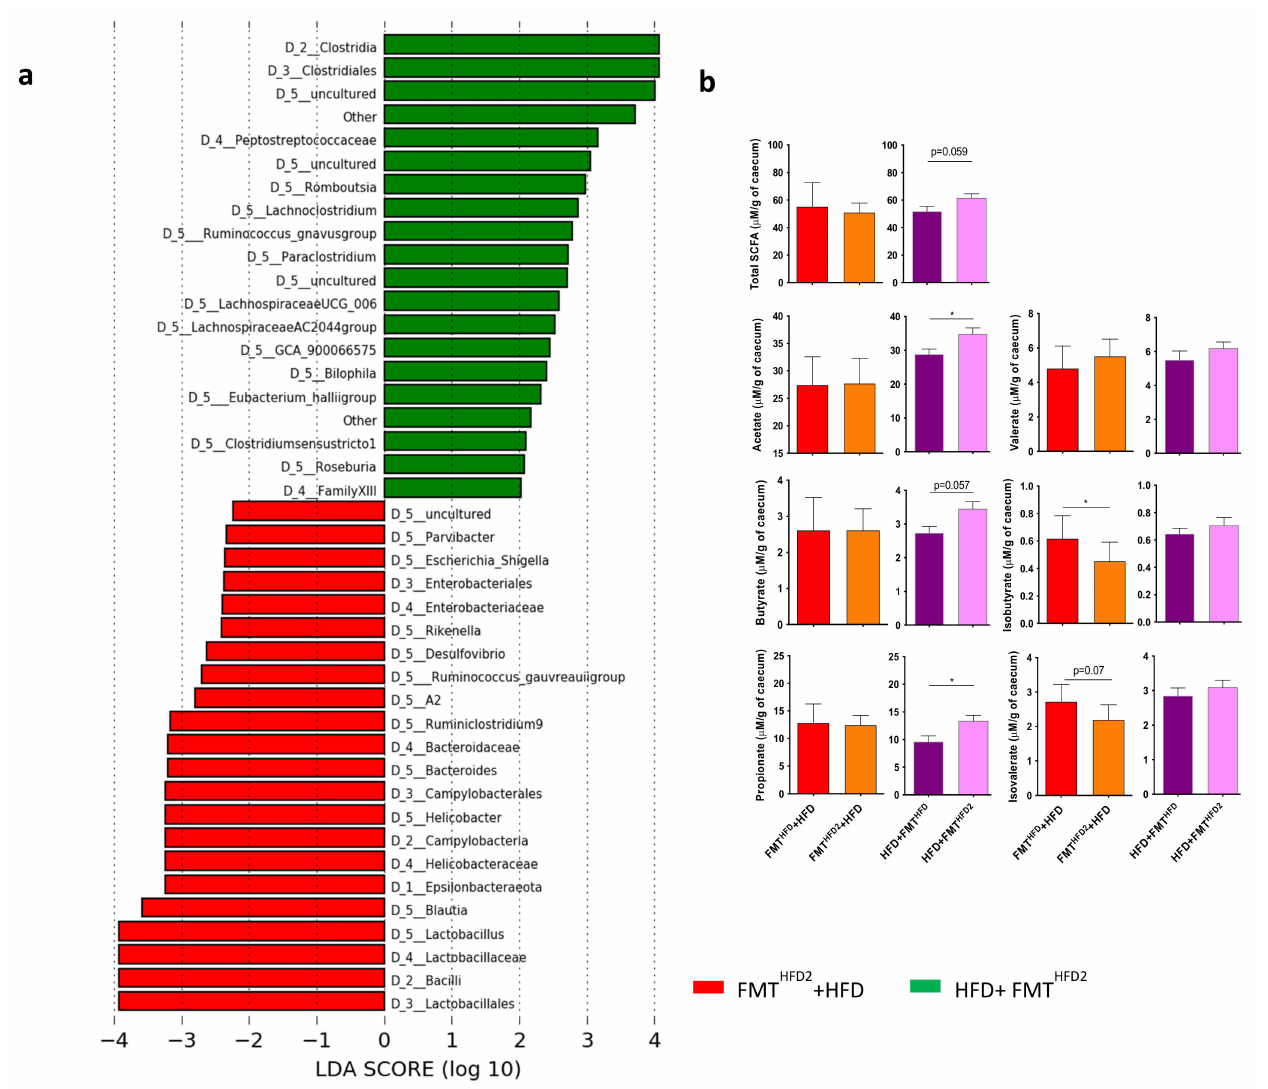
Figure 7. Curative and preventive FMT induce modifications of the IM and the proportion of SCFAs in cecal content. Mice received a preventive FMT before 16 weeks of HFD from donor mice fed an HFD (FMT HFD + HFD) or donor mice fed an HFD 2 (FMT HFD2 + HFD). Obese mice received a curative FMT before eight supplementary weeks of HFD from donor mice fed an HFD (HFD + FMT HFD ) or donor mice fed an HFD 2 (HFD + FMT HFD2 ): ( a ) LDA effect size (LEfSe) for the taxa enriched in mice receiving the IM of pectin-treated mice by preventive FMT HFD2 + HFD (red) or curative HFD + FMT HFD2 (green) treatment. Only taxa with a LDA score > 2 and p < 0.05, determined by the Wilcoxon signed rank test, are shown. ( b ) Cecal SCFA content induced by preventive and curative FMT ( µ M/mg of cecal content). Data represent the mean ± SEM of 9 or 12 mice. * p <